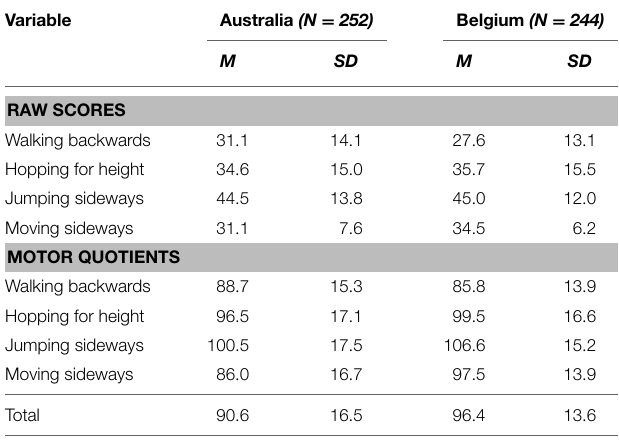
TABLE 2 | Means (M) and standard deviations (SD) of performance on the KTK (raw and standardized scores).